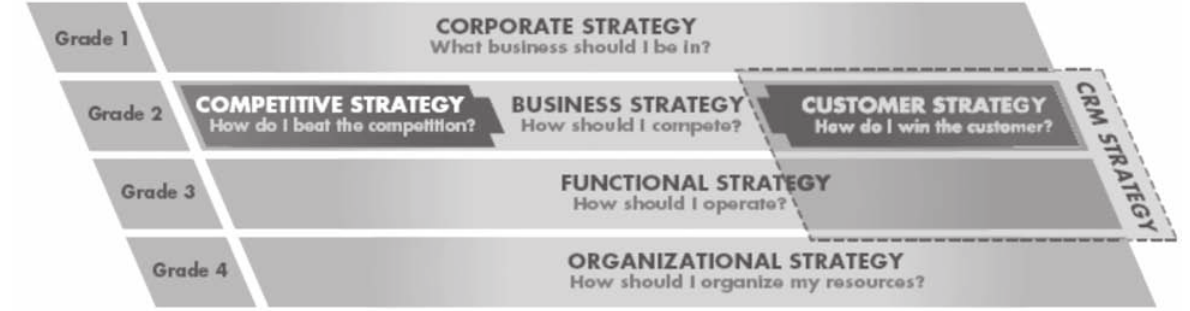
Fig 3. Grades of Strategy and CRM Strategy Fit